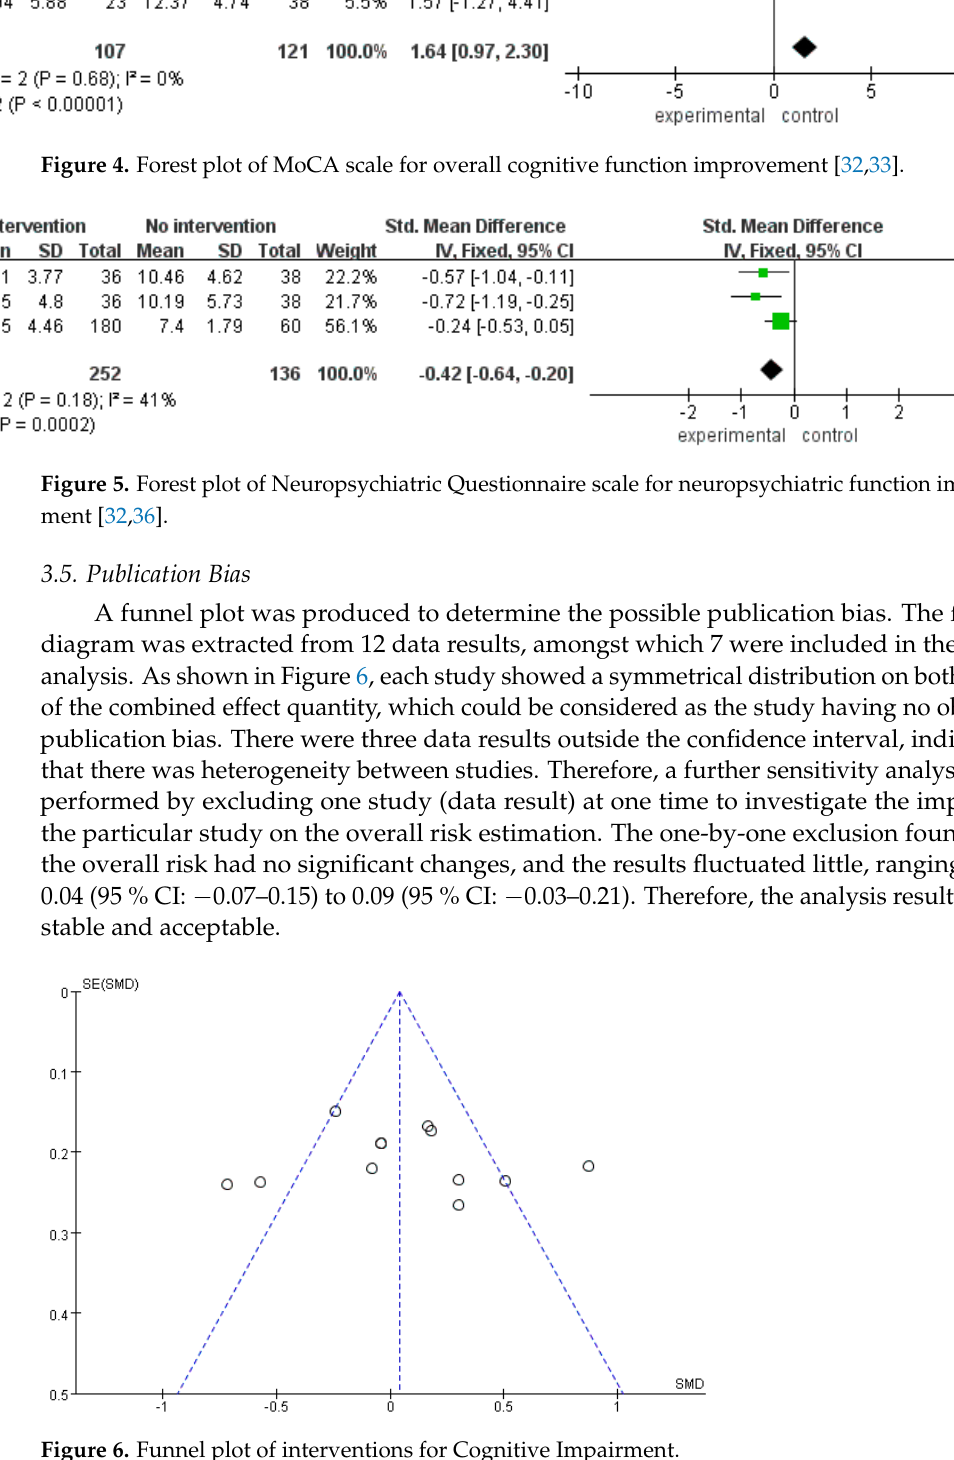
Figure 6. Funnel plot of interventions for Cognitive